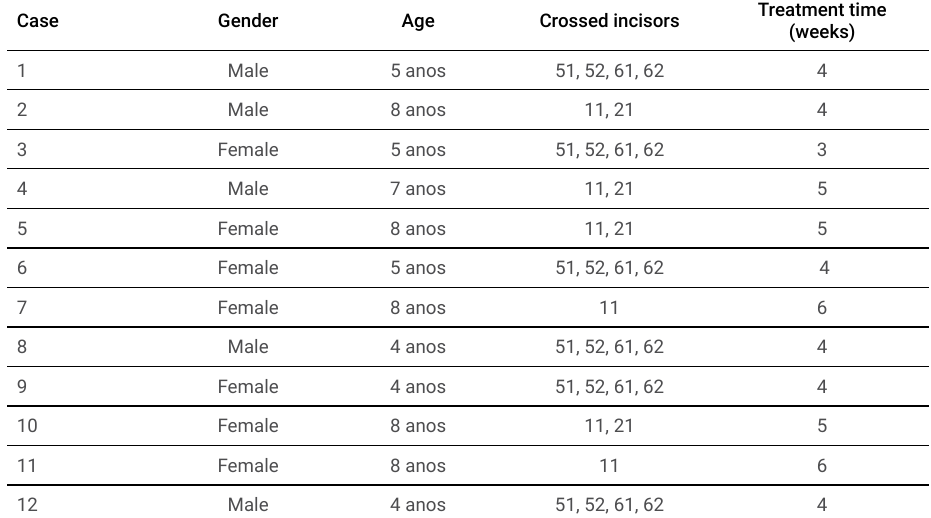
Table 1. Data of children who placed the plane inclined device